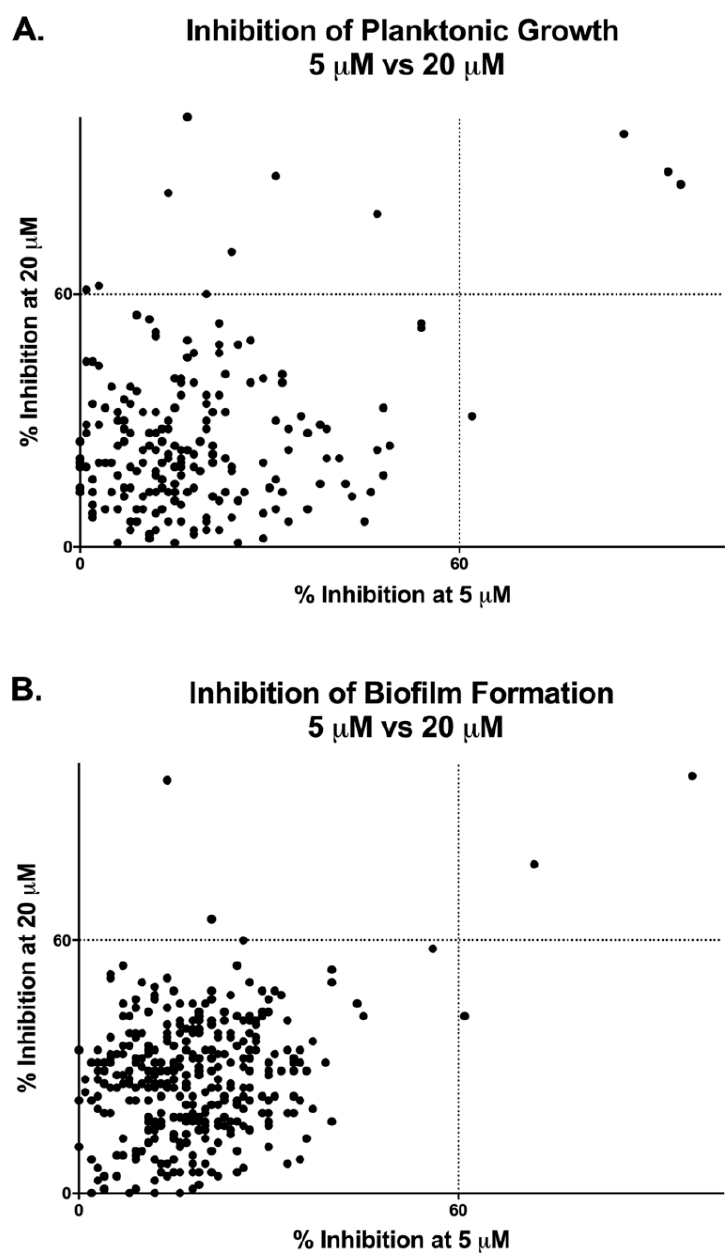
Figure 1. Graphical representation of results from primary screenings of the Pathogen Box ® in search for compounds with inhibitory activity against Candida auris strain 0390 under planktonic ( A ) and biofilm ( B ) growing conditions. Table 1. Identity and extent of inhibition of compounds identified as “hits” during primary screenings of the Pathogen Box ® in search for compounds with inhibitory activity against C. auris strain 0390 under planktonic and biofilm growing conditions.